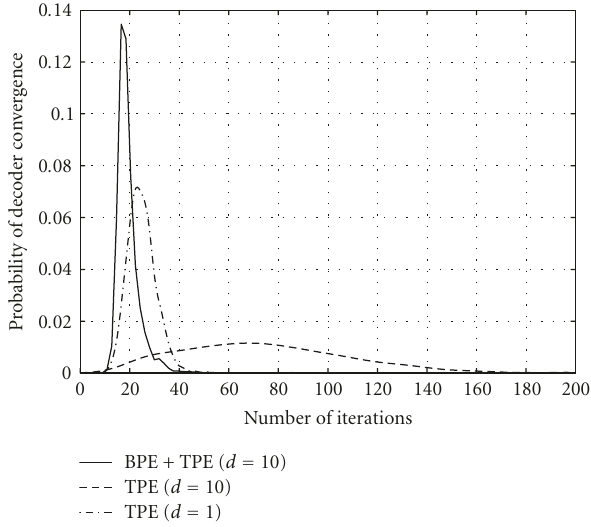
Figure 6: Convergence improvement due to an initial blind phase